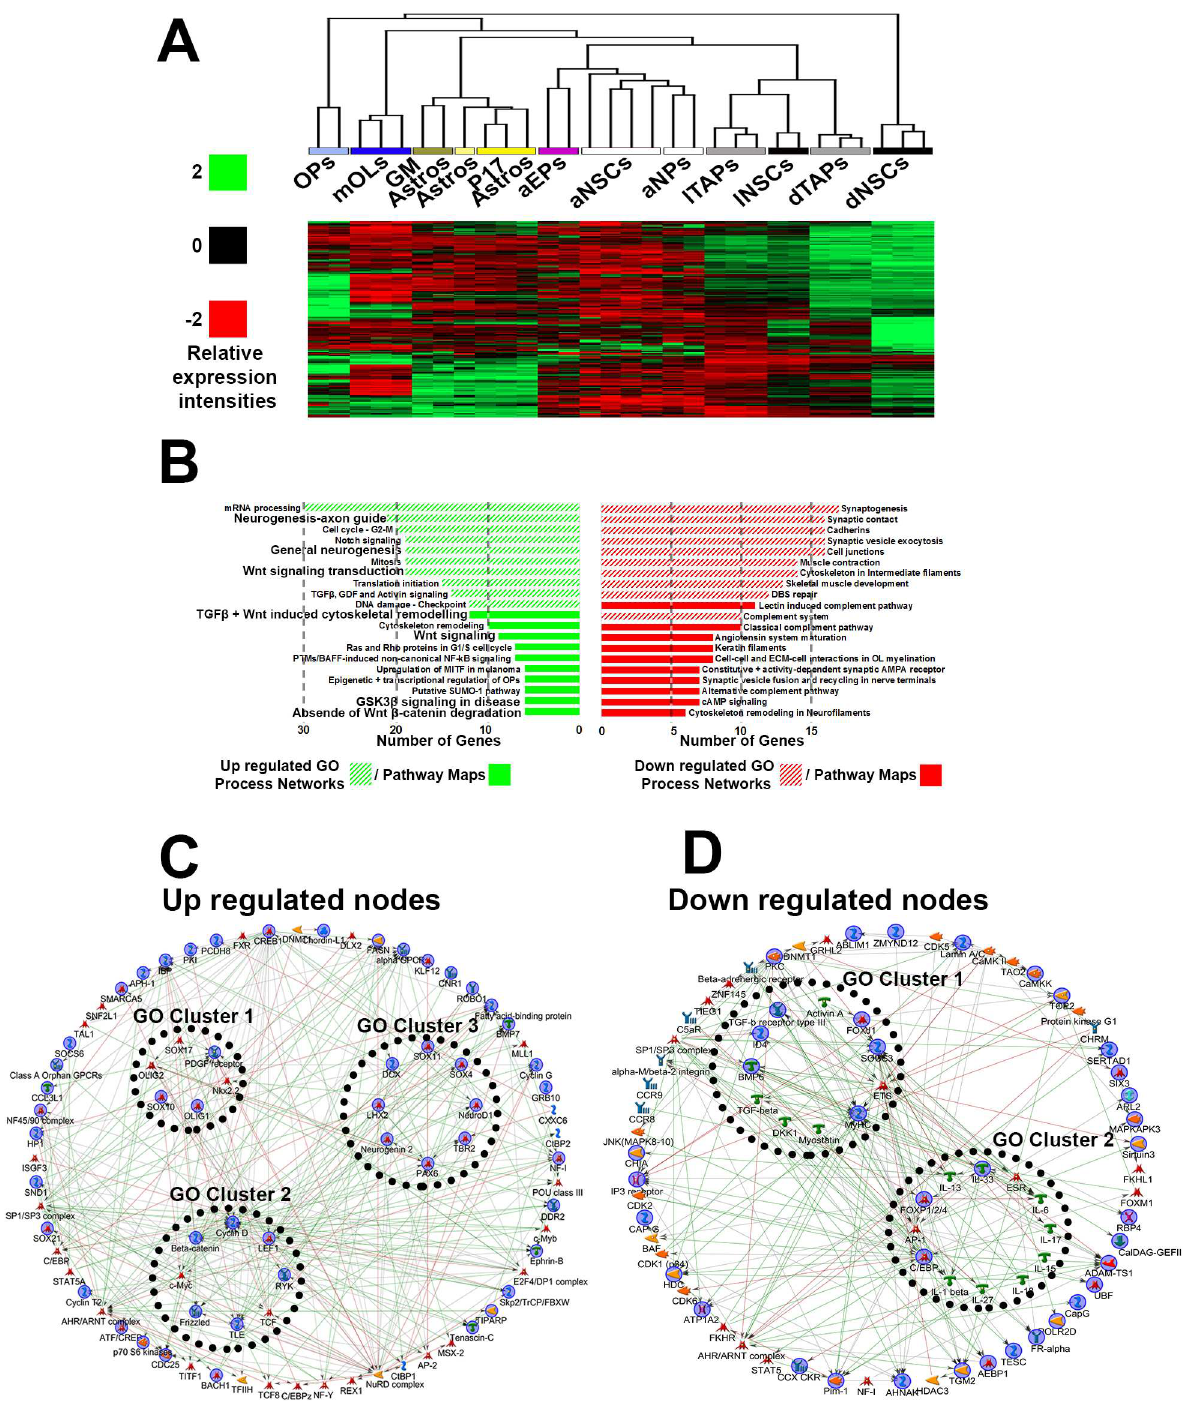
Fig 5. Connectivity map (CMAP) pathway and network analysis for AR-A014418 target genes. Gene list generatedto obtain the drug profiles for AR-A014418 (S6 Table) was utilized to compilethe CMAP “AR-A014418” target-gene list, and genesprospectively up- regulatedare presented as a heatmapin (A) showingenrichment in earlierpostnatal dorsalsubventricular zone (dSVZ) cells. aEPs, adult ependymas; aNPs, adult neuronalprecursors; GM, grey matter; astros, astrocytes; mOLs, mature/myelinatingoligodendrocytes; aNSCs, adult neuralstem cells (NSCs); dNSCs, dorsal NSCs; dTAPs, dorsaltransient amplifyingprogenitors (TAPs); lNSCs, lateral NSCs; lTAPs, lateral TAPs. (B) Prospectively up-regulated or down-regulated genesanalyzedby GenegoMetacore for GO Pathway Maps and Process Networks, and lists are ranked accordingto significance(false discovery rate [FDR] < 1%)/numbers of genespresent in each of